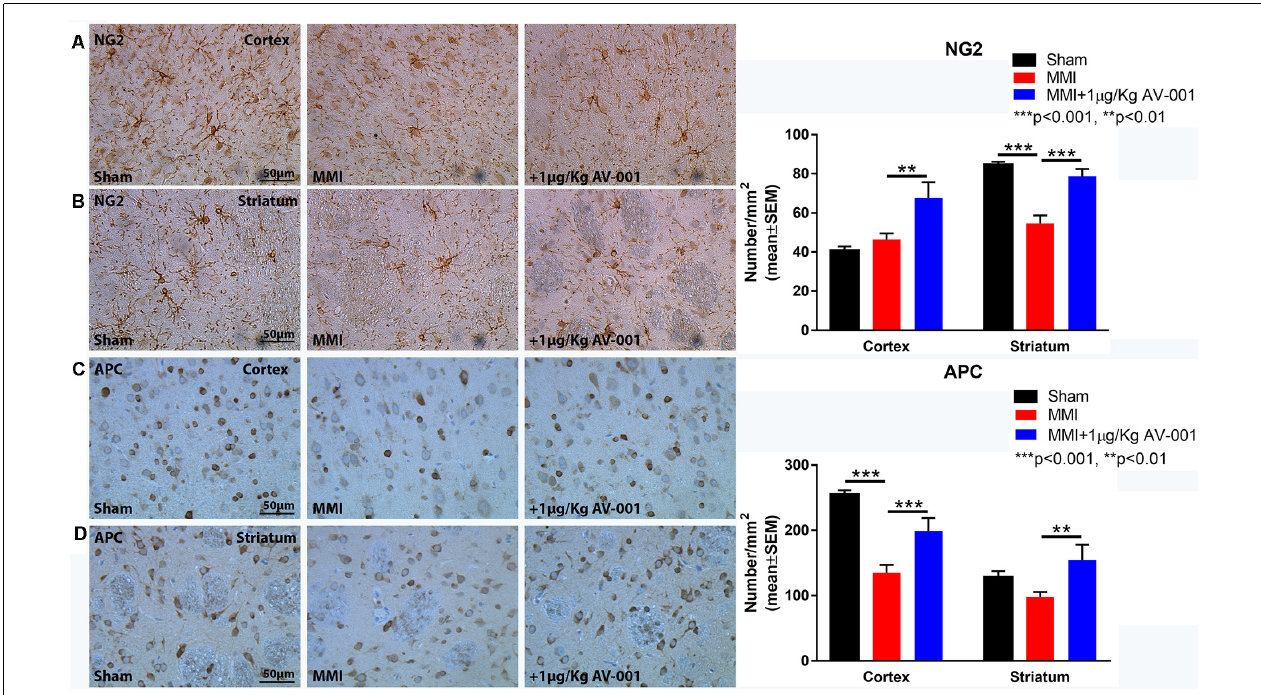
FIGURE 6 | AV-001 treatment significantly increases oligodendrocyte progenitor cells and oligodendrocytes in the brain of middle-aged rats subjected to MMI. (A,B) Representative images and quantification data of NG2 immunostaining in the Cortex and Striatum brain regions. MMI significantly reduces the number of oligodendrocyte progenitor cells in the striatum compared to Sham control rats. 1 µ g/Kg AV-001 treatment significantly increases the number of oligodendrocyte progenitor cells in the Cortex and Striatum compared to the MMI control group. (C,D) Representative images and quantification data of APC immunostaining in the Cortex and Striatum brain regions. MMI significantly reduces the number of oligodendrocytes in the cortex compared to Sham control rats. 1 µ g/Kg AV-001 treatment significantly increases the number of oligodendrocytes in the Cortex and Striatum and oligodendrocyte progenitor cells in the striatum compared to the MMI control group.